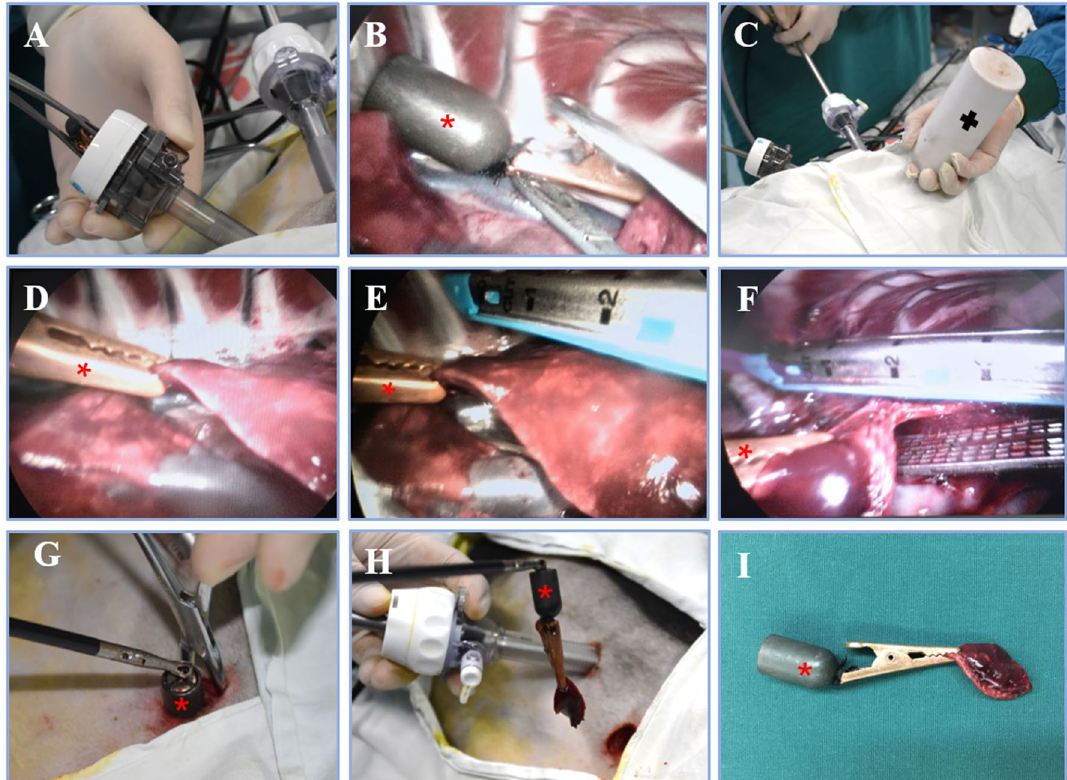
Figure 4. Intraoperative photographs showing the use of magnetic anchoring device to assist thoracoscopic surgery. ( A ) Use of titanium alloy forceps to insert the internal grasper into the body. ( B ) The internal grasper is clamped in a suitable position. ( C ) The position of the external anchoring magnet was moved to change the position of the internal grasper. ( D ) Assist in the exposure of lung fissures. ( E, F ) Assist in resection of lung tissue. ( G, H ) The internal grasper and target lung tissue is taken out. ( I ) The removed internal grasper and target lung tissue. (“*” shows the internal grasper, “ + ” shows the anchoring